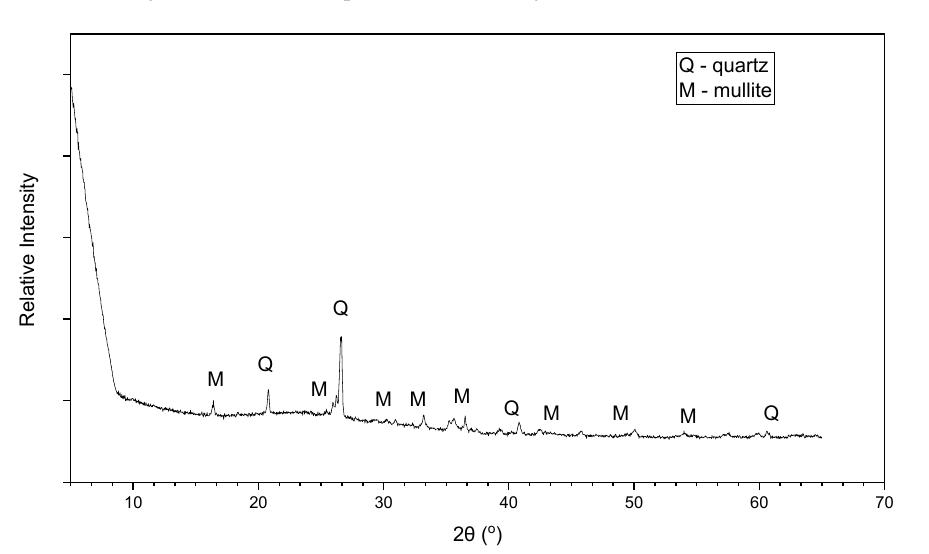
Figure 4. X-ray diffraction (XRD) pattern of class F fly ash.